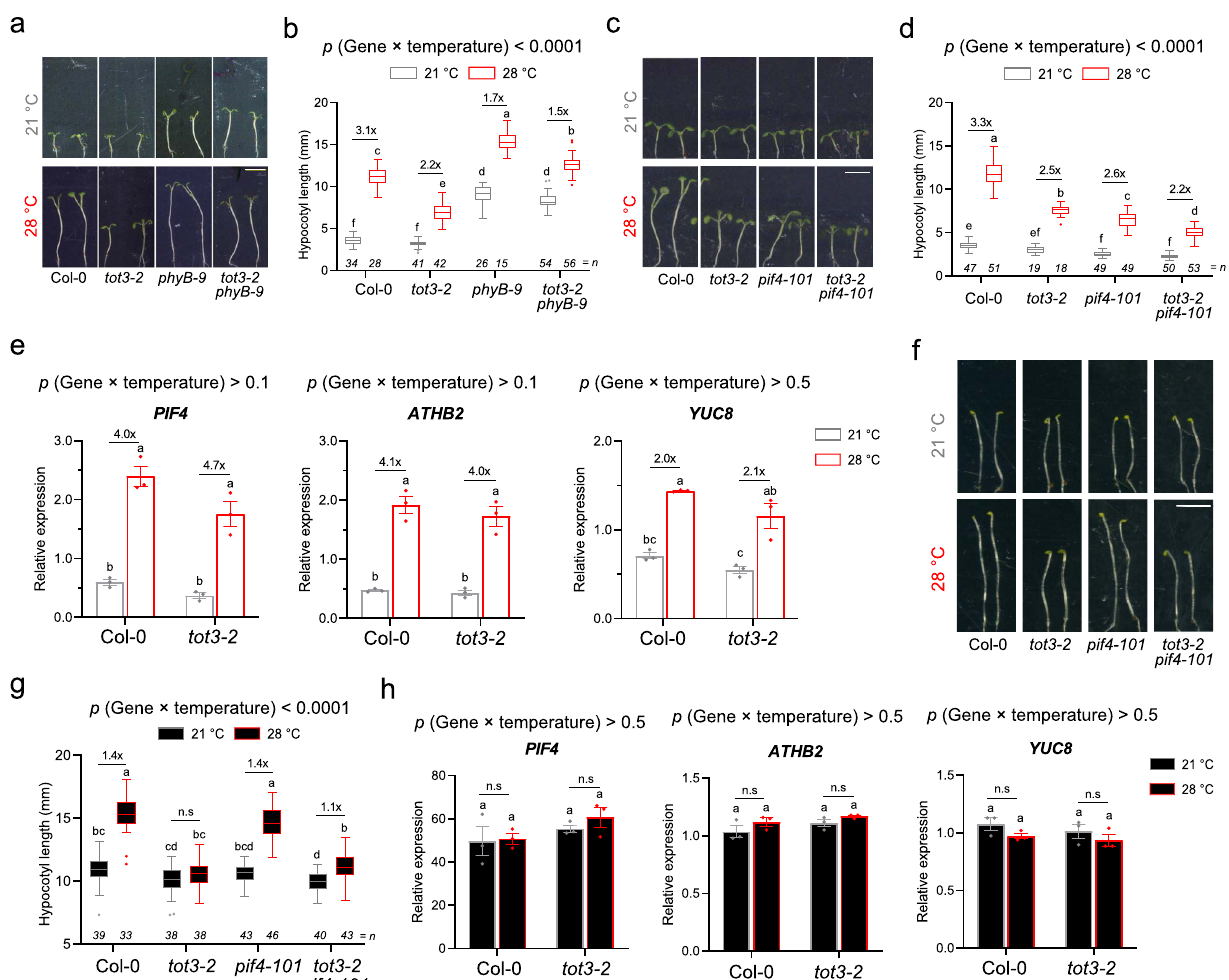
Fig. 4 TOT3 regulates thermomorphogenesis independently from light signalling. a – d Genetic interaction between 7-day-old tot3-2 and phyb-9 ( a , b ) (15 ≤ n ≤ 54) and pif4-101 ( c , d ) (18 ≤ n ≤ 53) at 21 and 28 °C under short-day conditions. Representative pictures ( a , c ) and hypocotyl length quanti fi cation ( b , d ). Scale bar, 5 mm ( a , c ). e Relative expression of temperature-responsive genes in 3-day-old Col-0 wild-type and tot3-2 seedlings in control (21 °C) and warm-temperature conditions (28 °C) under short-day conditions. f , g Genetic interaction between 3-day-old tot3-2 and pif4-101 at 21 and 28 °C in darkness. Representative pictures ( f ) and hypocotyl length quanti fi cation ( g ). Scale bar, 5 mm ( f ). h Relative expression of temperature-responsive genes in 3-day-old Col-0 wild-type and tot3-2 seedlings in control (21 °C) and warm-temperature conditions (28 °C) in darkness. Box plots show median with Tukey-based whiskers and outliers ( b , d , g ). The number of individually measured seedlings ( n ) is indicated above the X -axis ( b , d , g ). Bar diagram shows mean of 3 biological replicates (individual dots) with standard error of the mean ( e , h ). For the quantitative fi gures, letters indicate signi fi cant differences based on two-way ANOVA and Tukey ’ s test ( p < 0.01) with fold-change between 21 and 28 °C being presented; n.s: not signi fi cant. The p -value for the interaction (genotype × temperature) is shown at the